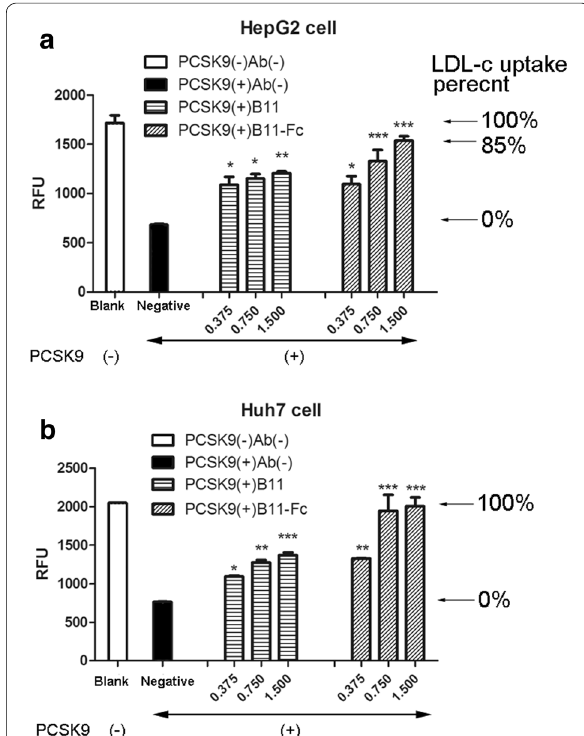
Fig. 6 The LDL-uptake test in HepG2 ( a ) and Huh7 ( b ) cell models. The horizontal axis represents four different groups. The vertical axis represents the relative fluorescence unit (RFU) of the intracellular LDL, which reflects the levels of the LDL-c uptake and functional LDLR at the cell surface. The left two columns were respectively taken as the blank (full white) and negative (full black) control groups. The right six columns represent the other two groups of the monovalent VHH-B11, and the bivalency B11-Fc respectively in three doses (0.375, 0.750 and 1.500 μM). LDL-c uptake percent was given on the right of the histogram ( ). ‘( )’ and ‘( )’refers to the addition and absence ← + − of hPCSK9 or VHH derivative antibodies, respectively. P < 0.05 was considered as statistically significant, compared with the negative control group (* P < 0.05, ** P < 0.01, *** P <